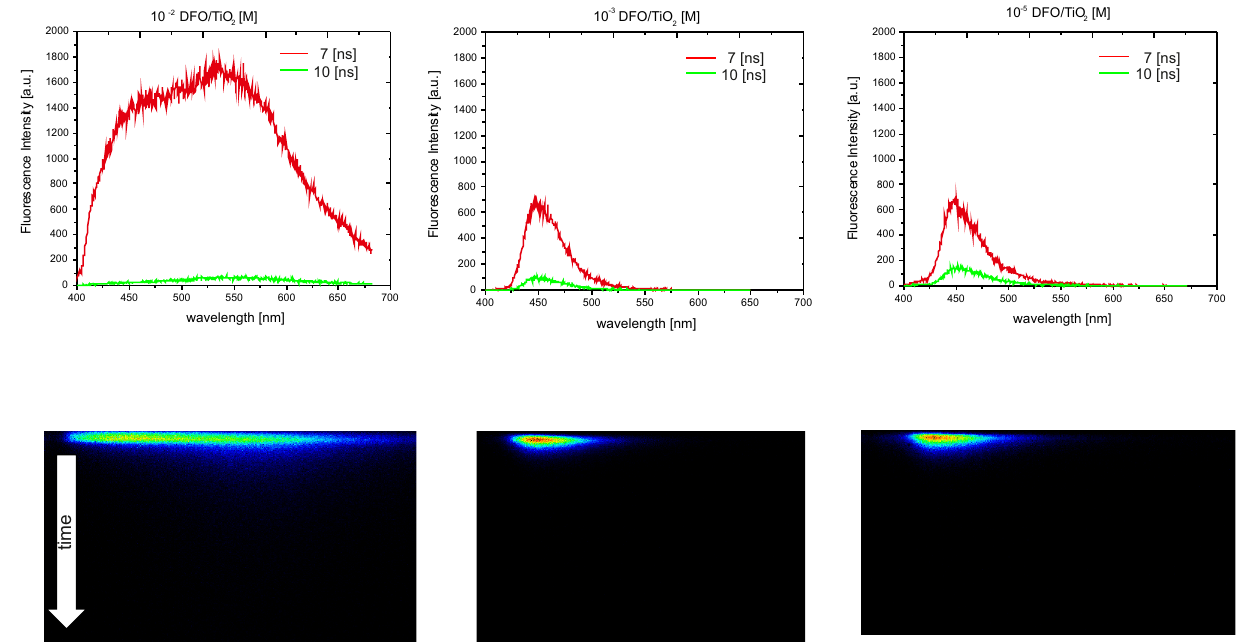
Figure 3. Time-resolved emission spectra of DFO/TiO 2 thin films for different DFO concentrations: 10 − 2 [M] DFO/TiO 2 ; 10 − 3 [M] DFO/TiO 2 ; 10 − 5 [M] DFO/TiO 2 . The excitation wavelength was 380